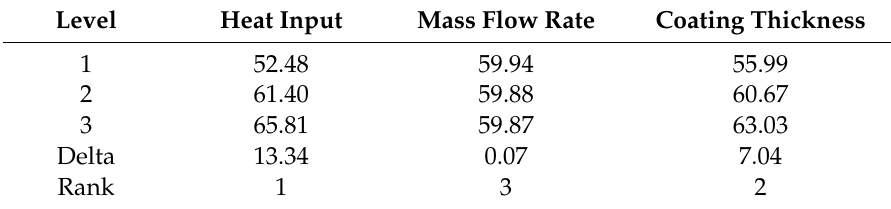
Table 14. Response Table for SNRA.